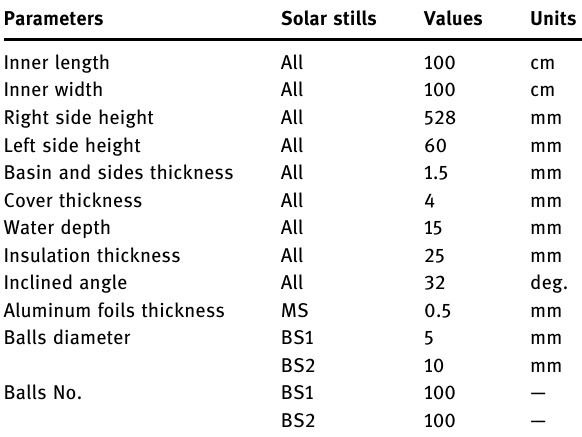
Table 1: Properties of the CS and modi fi ed solar stills